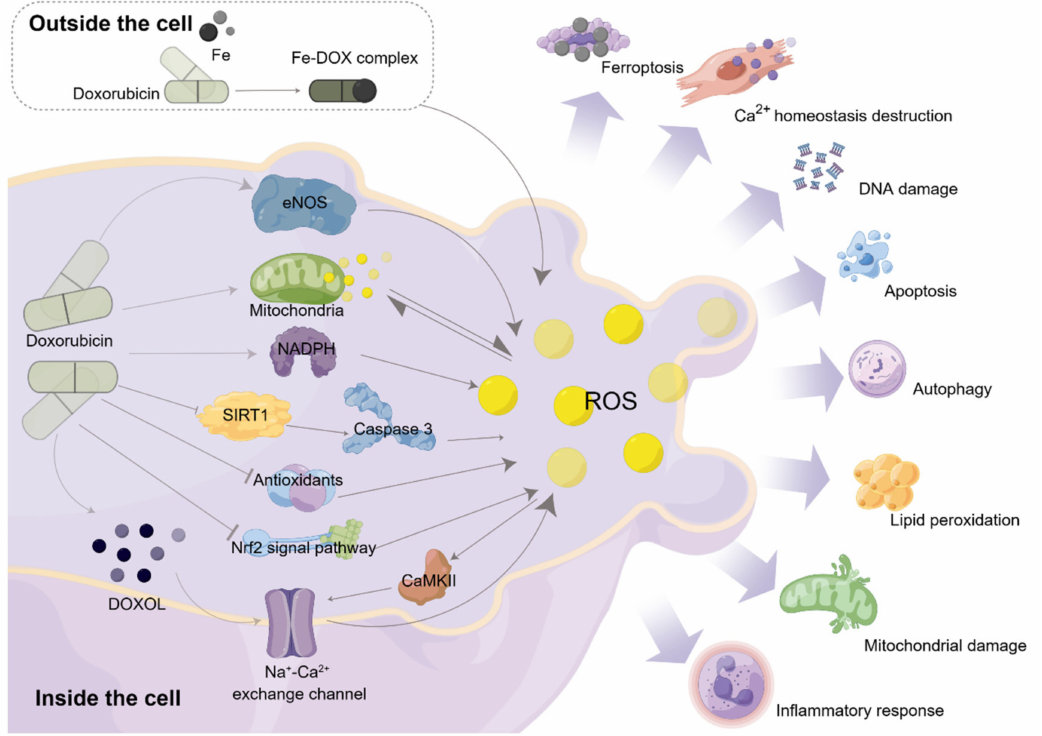
Figure 3. Schematic diagram of the occurrence and development of oxidative stress in DIC. DOX enters the body and produces ROS mainly through the following ways, mediating oxidative stress; DOX combines with eNOS to induce DOX, generating ROS; DOX binds to the inner mitochondrial membrane to form complexes, alters cardiolipin function, and produces ROS; DOX forms Fe-DOX complexes with Fe, which contribute to ROS production; under the action of the NOX enzyme, DOX reacts with NADPH to generate ROS; DOXOL, a metabolite of DOX, inhibits the sodium-calcium exchange channel, causing an imbalance in the level of Ca 2+ in the cell, and produces ROS, which inhibits CaMKII and aggravates the imbalance of Ca 2+ level; excessive consumption of antioxidants; downregulation of Nrf2 pathway expression; DOX treatment significantly inhibited SIRT1 deacetylase activity and protein levels, and promoted deubiquitination of p53 and activation of caspase-3. The above seven ways are involved in DOX-induced oxidative stress, individually or